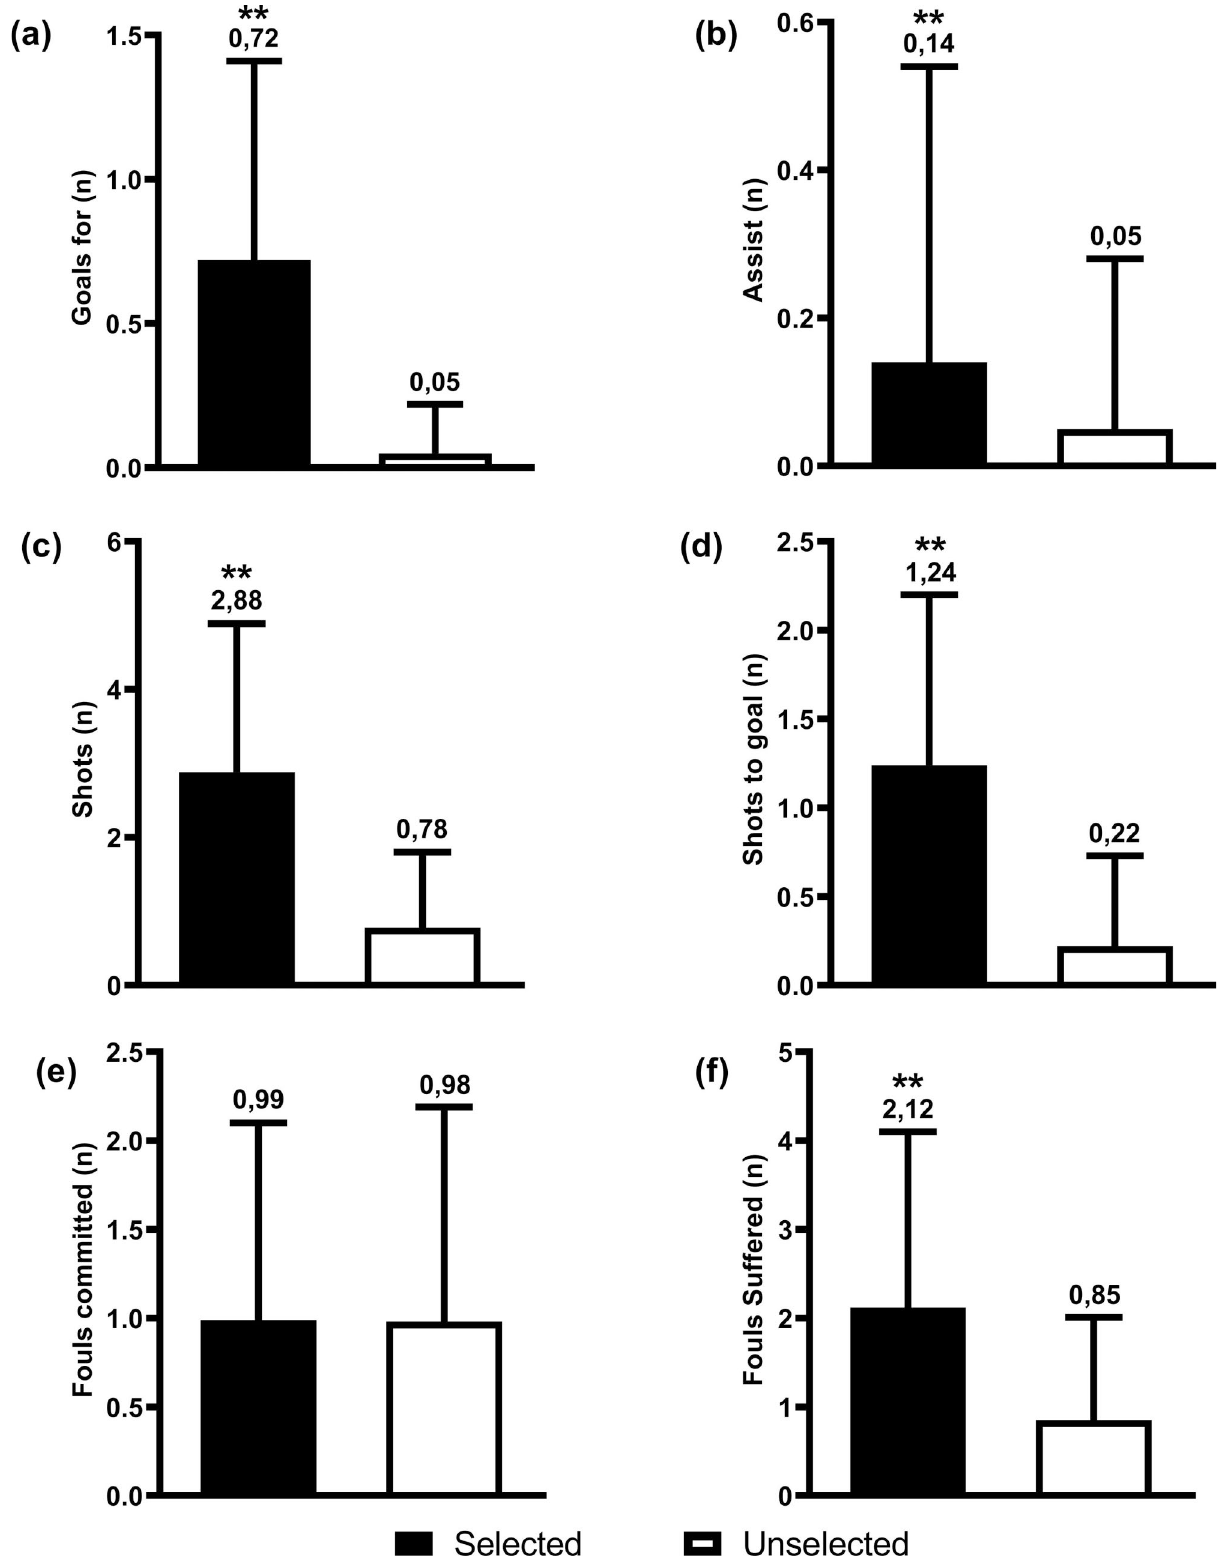
Figure 2 - Technical variables of soccer players. Black bars: selected players. White bars: unselected players. ∗ statistically significant difference (p < 0.05); ∗∗ statistically significant difference (p <